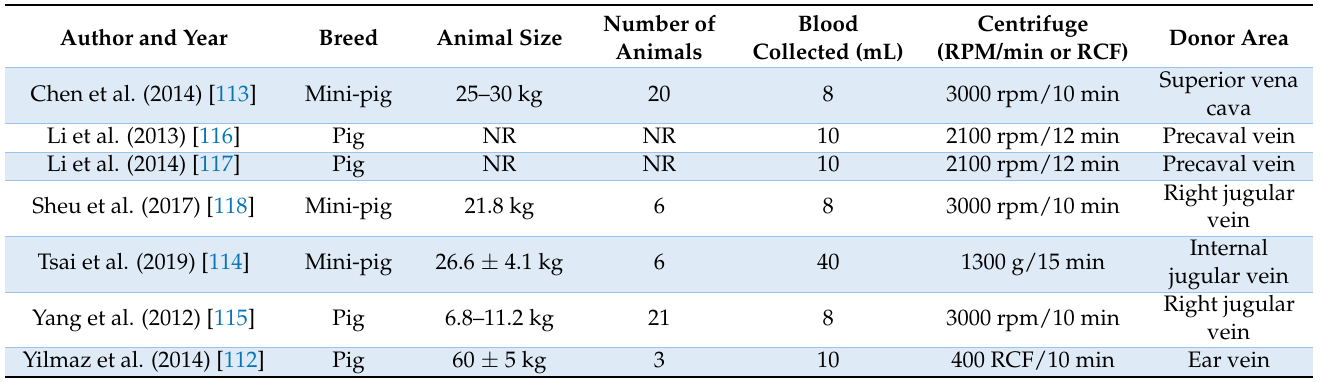
Table 4. Data was collected from the PRF process using the pig